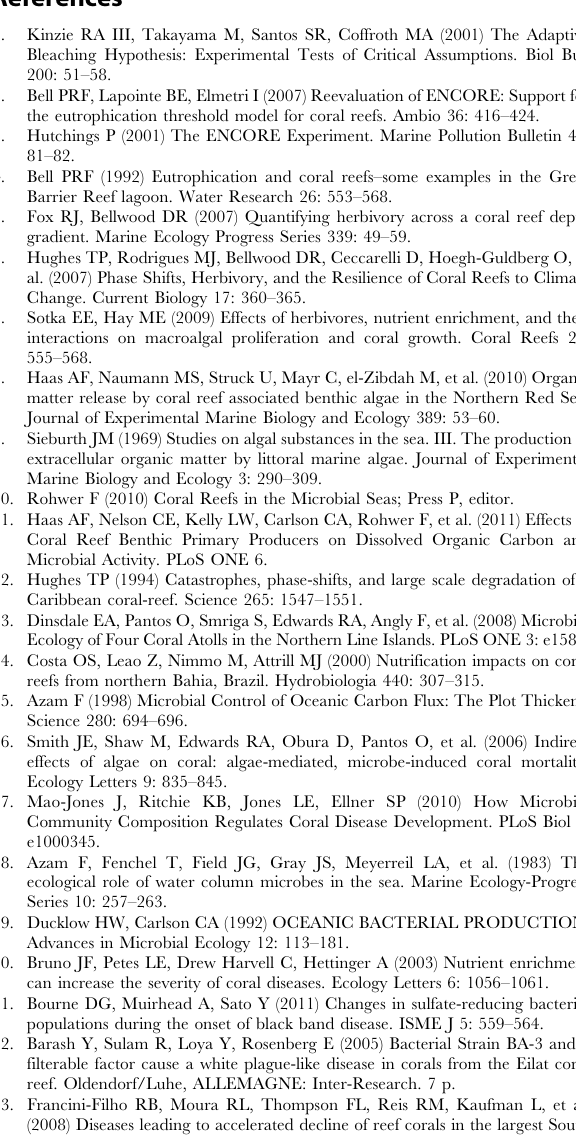
Figure S5 Contribution of subsystems (hierarchy 1) in 2009 and 2010. Bars indicate the contribution of the sequences for each subsystem of the five reefs analyzed. Only informative sequences were used for subsystems identification. The sequences were assigned as Miscellaneous Subsystems, and Unknown or Clustered Based Subsystems were not included. Table S1 Distribution of the sequences used to charac- terize microbial community structure. The number of sequences assigned is indicated for each analysis performed. Table S2 Diversity and abundance of subsystems hierarchy 3 (carbohydrate, nitrogen, phosphorous, virulence, stress response and photosynthesis metabo-